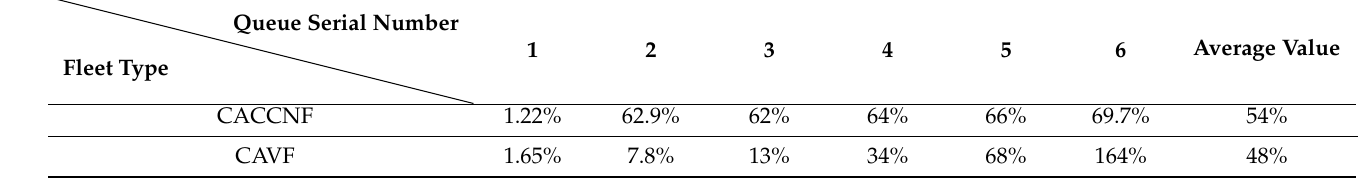
Table 2. Comfort degree of CAVF fleet and CACCNF